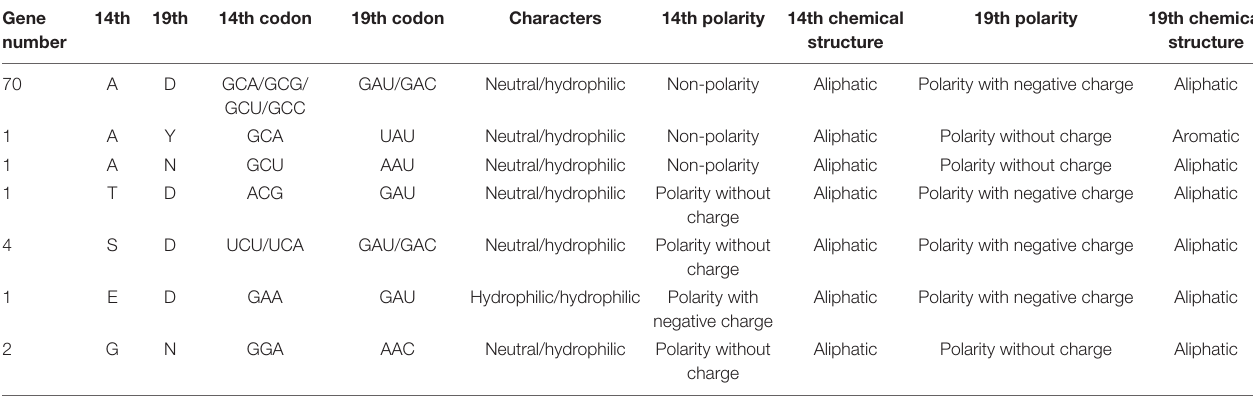
TABLE 2 | The 14th/19th amino acid analysis of the ERF subfamily AP2